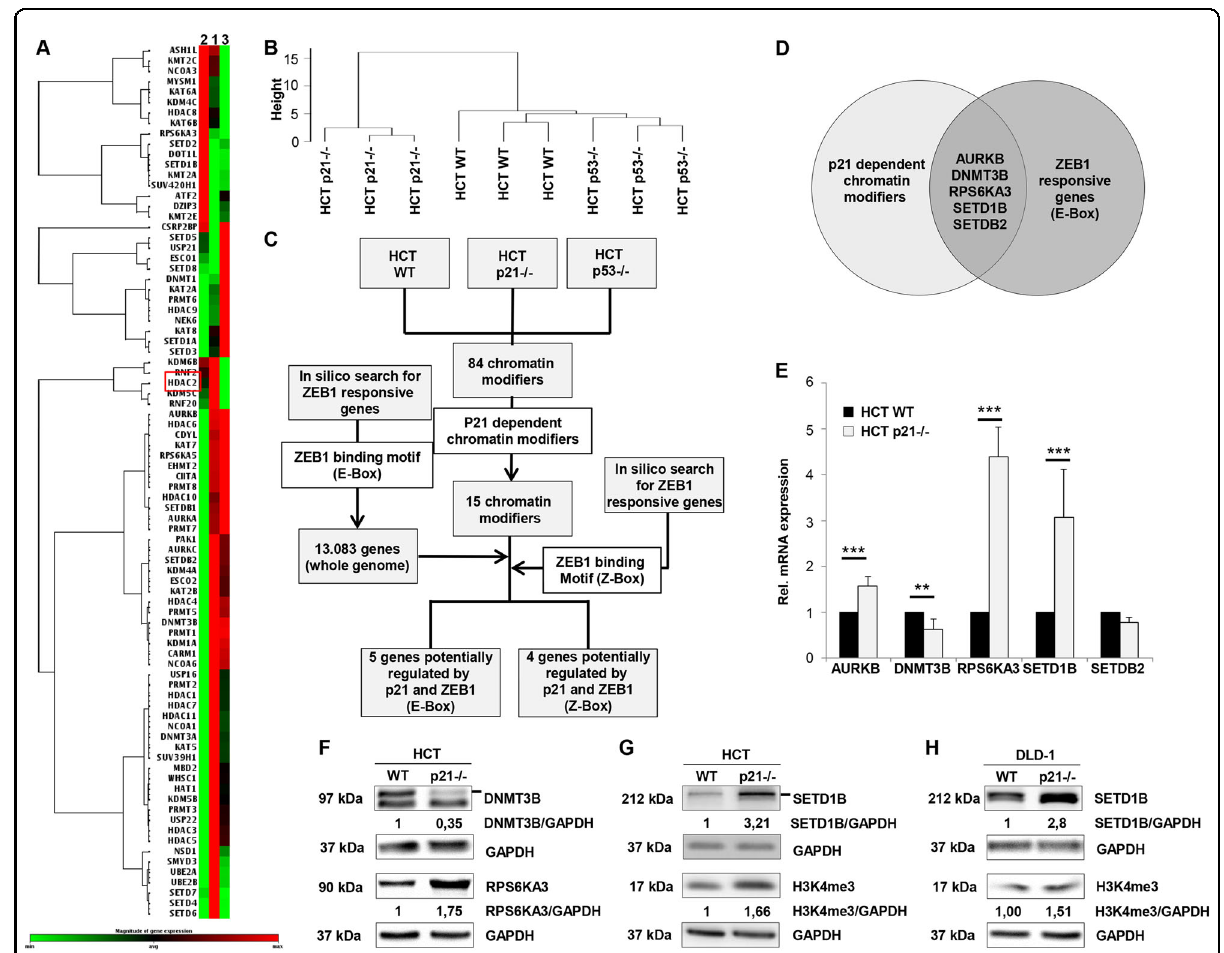
human chromatin modi fi cation enzymes) of HCT cell lines analyzed by RT² PCR Pro fi ler Array; n = 3. b Hierarchical dendrogram clustering of samples from RT 2 Pro fi ler PCR Array data. c Combination of statistical analysis of RT² Pro fi ler PCR Array Dataset and genome wide search for ZEB1